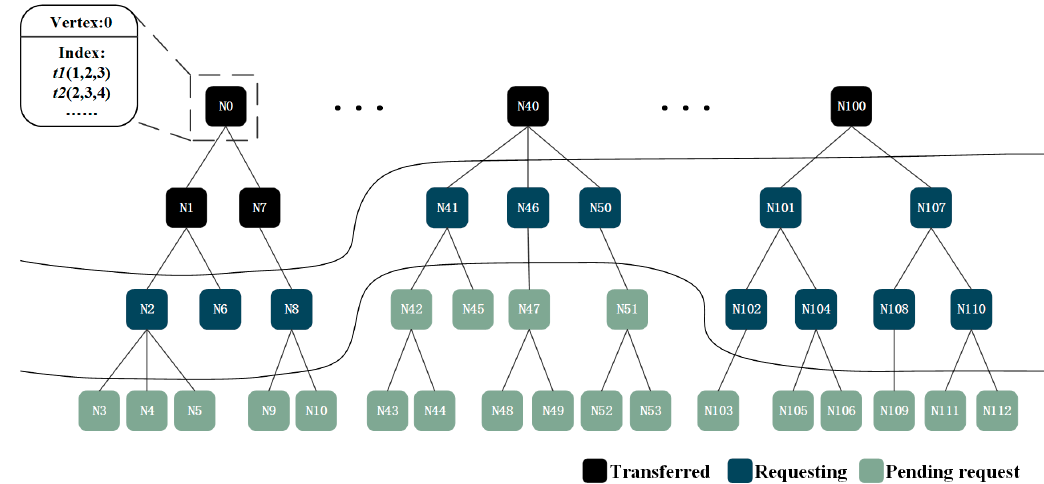
Figure 7. Data scheduling: The black node indicates that it has been transmitted; the dark blue node indicates that it is being requested; the green node indicates that it is not needed at the moment.